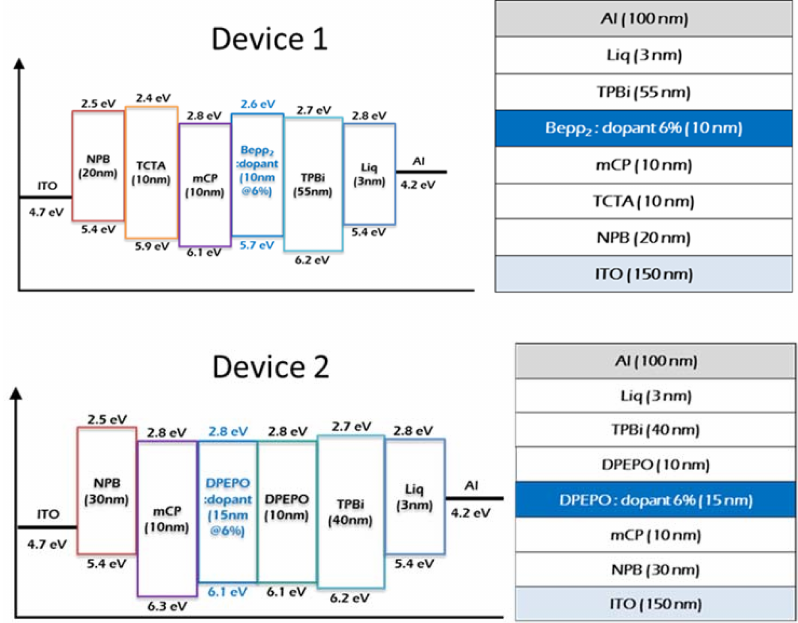
Figure 4. The fabricated device structures of 1 and 2 based on fluorescent